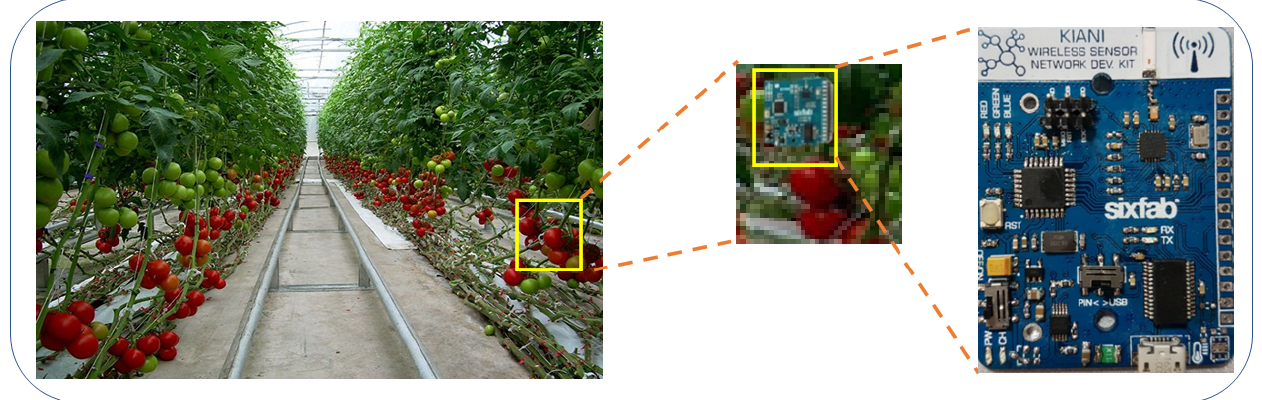
Figure 2. The device used as an IoT node in the field [5,55].